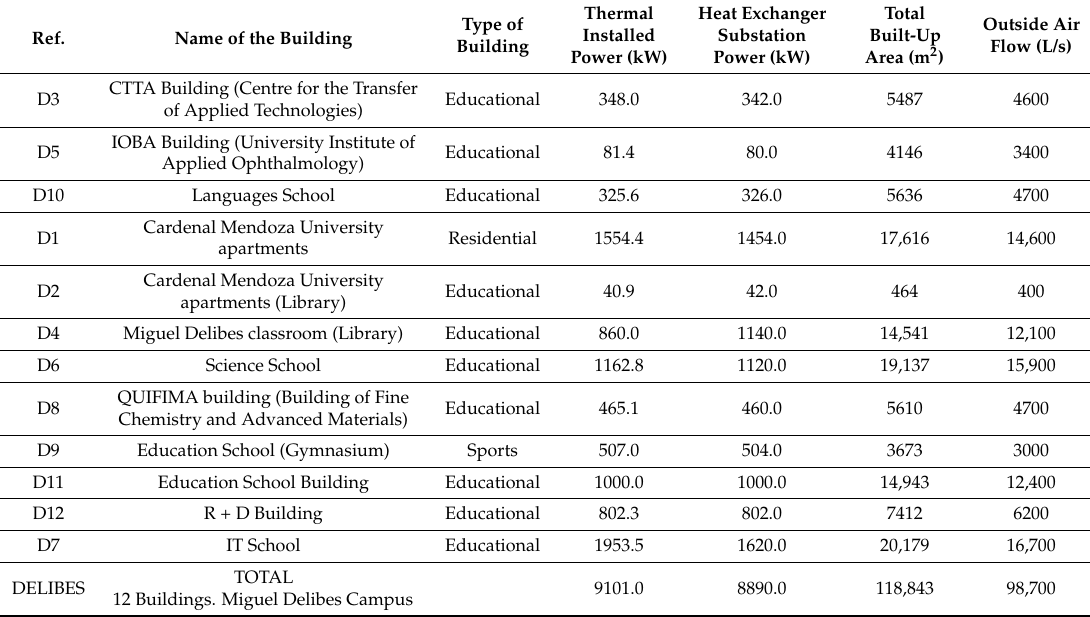
Table 1. Buildings, installed thermal power and heat exchanger power in their facilities. Ref.